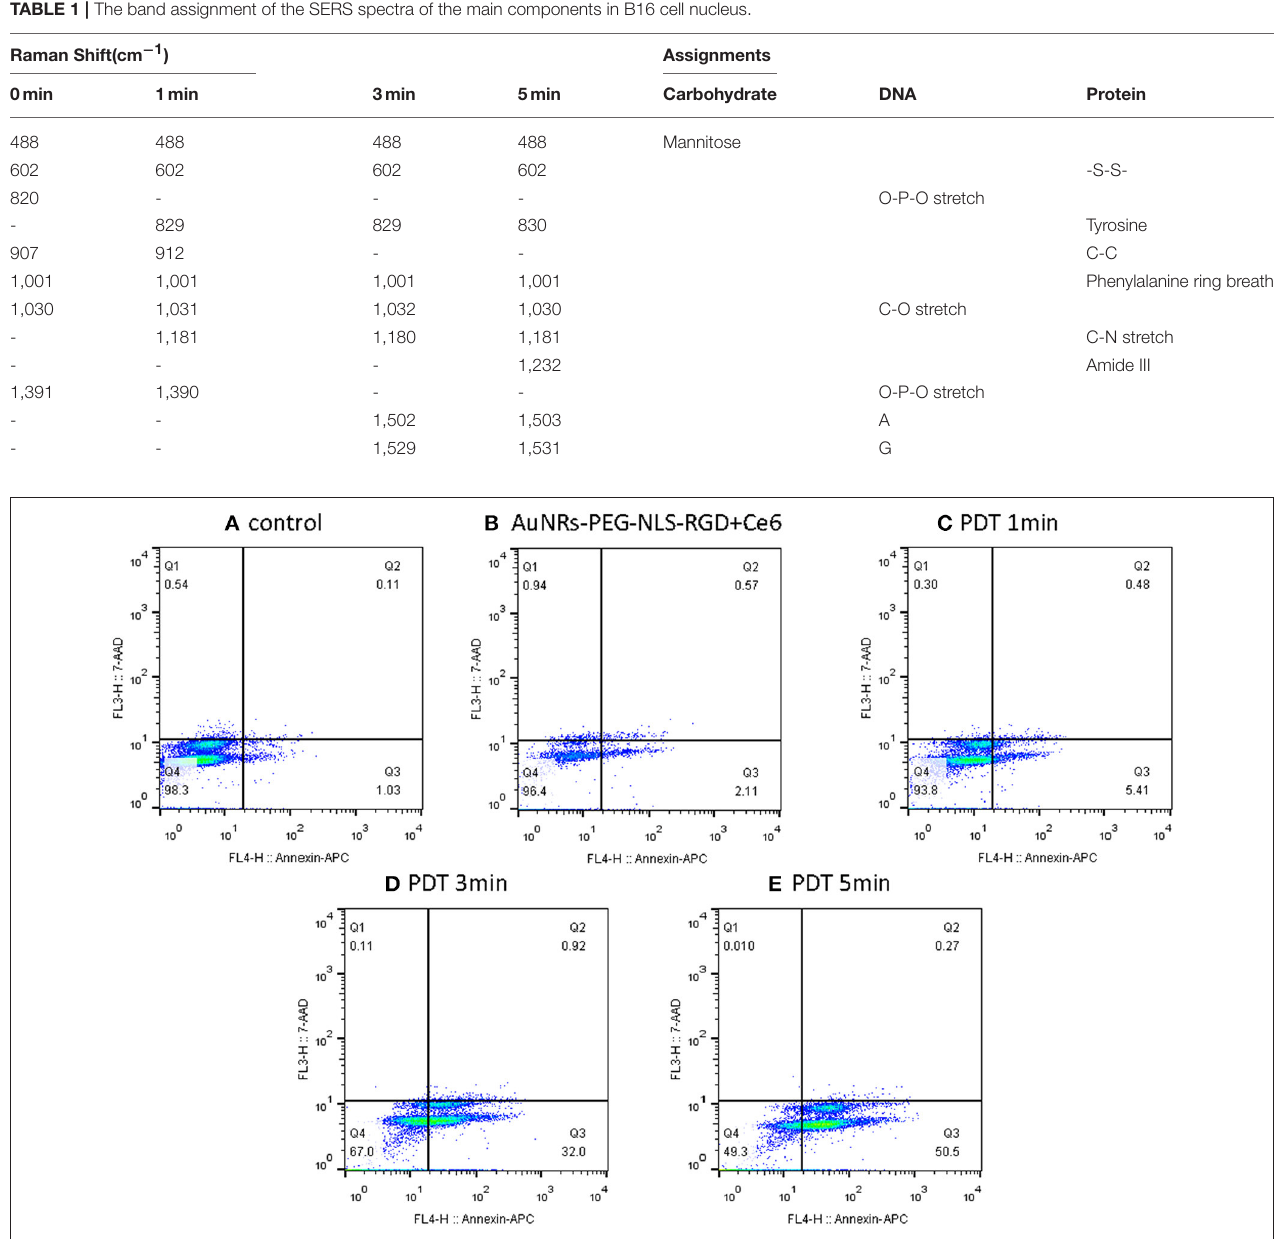
FIGURE 7 | Flow cytometry (apoptosis/necrosis assay) for the B16 cells treated with nanoprobes and Ce6 before (B) and after light irradiation with different time (C–E) , while the B16 cells without any treatment was used as a control (A) . Cells were labeled with Annexin V-APC and 7-aminoactinomycinD (7-AAD) and measured by the FACSCalibur (BD Biosciences, USA). Q1- Q4 indicate necrosis, late apoptosis, early apoptosis and viable,